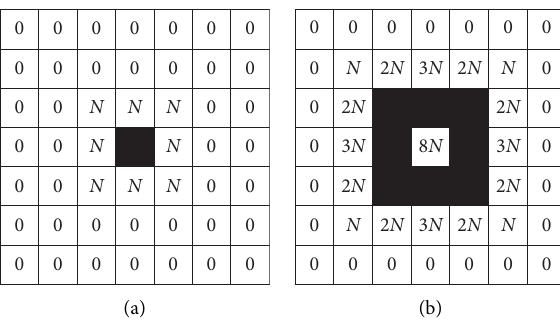
Figure 4: Development potential in the neighboring